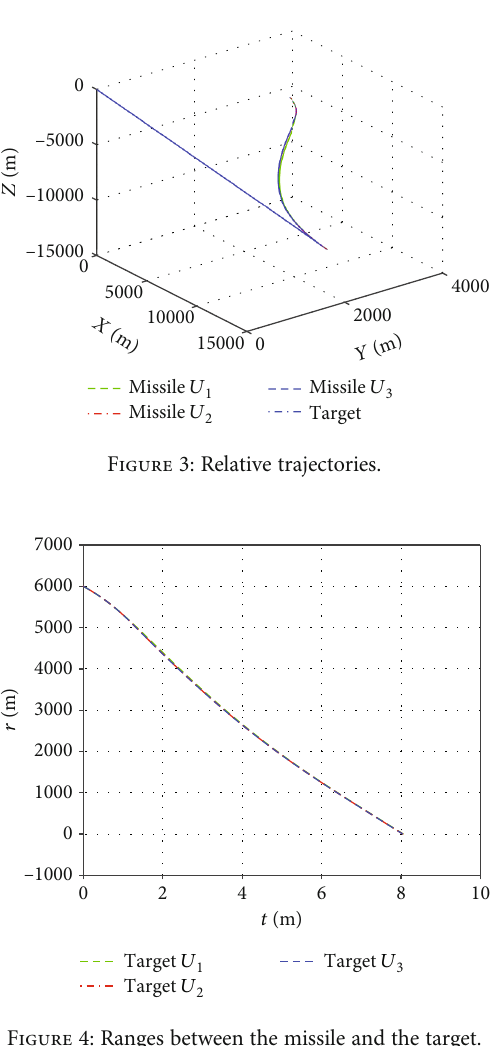
Figure 7: Direction angles θ